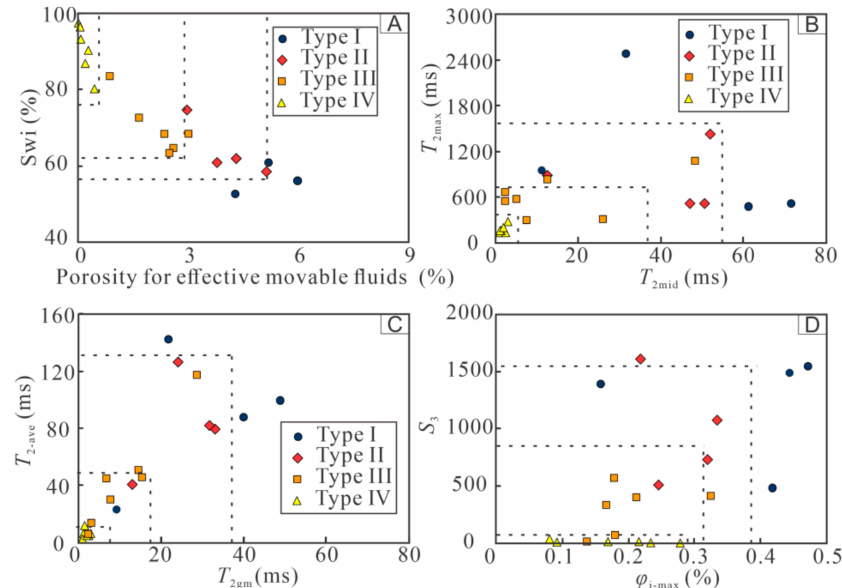
Figure 17. NMR T 2 spectral parameters of four types of pore structures: ( A ) ϕ em versus S wi ; ( B ) T 2mid versus T 2max ; ( C ) T 2gm versus T 2ave ; ( D ) ϕ i-max versus S 3